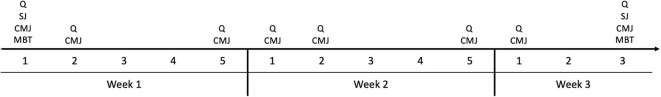
Timeline of study design. Q, questionnaire; SJ, squat jump; CMJ, countermovement jump; MBT, medicine-ball throw.